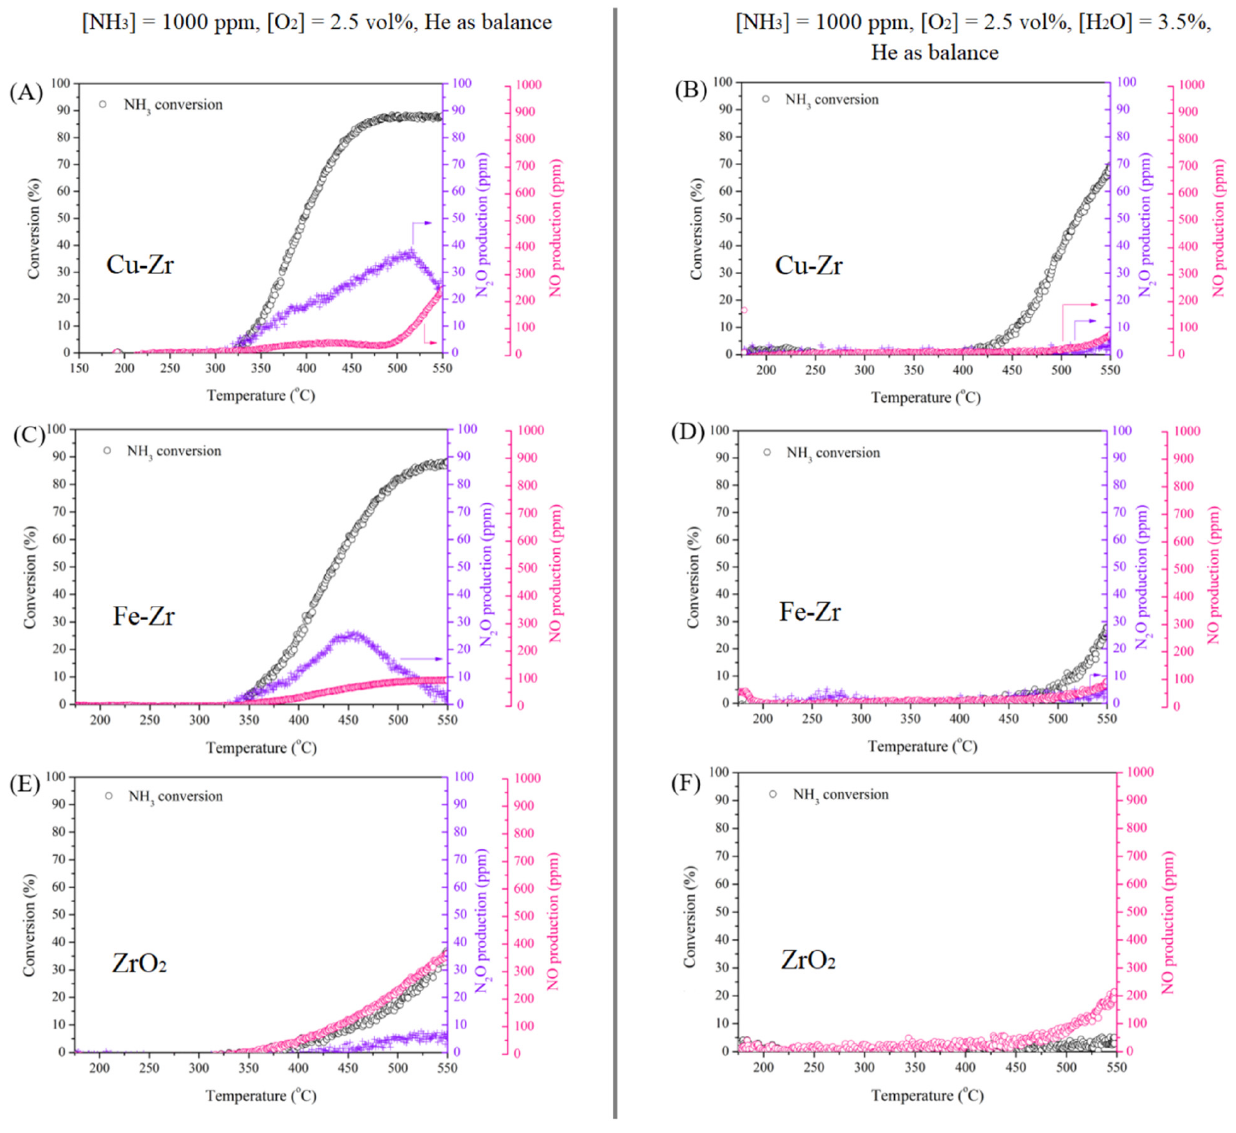
Figure 6. NH 3 conversion profile and N 2 O and NO production profiles as a function of temperature in NH 3 -SCO over Cu-Zr catalyst ( A ) in absence of water, ( B ) in presence of water; Fe-Zr catalyst ( C ) in absence of water, ( D ) in presence of water; and ZrO 2 support ( E ) in absence of water, ( F ) in presence of water. The experimental conditions: [NH 3 ] = 1000 ppm, [H 2 O] = 3.5 vol% when used, [O 2 ] = 2.5 vol% diluted in helium; total flowrate of 100